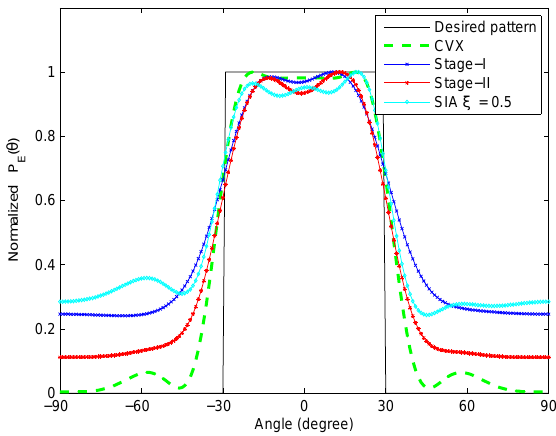
Figure 12. The optimized beampatterns for the